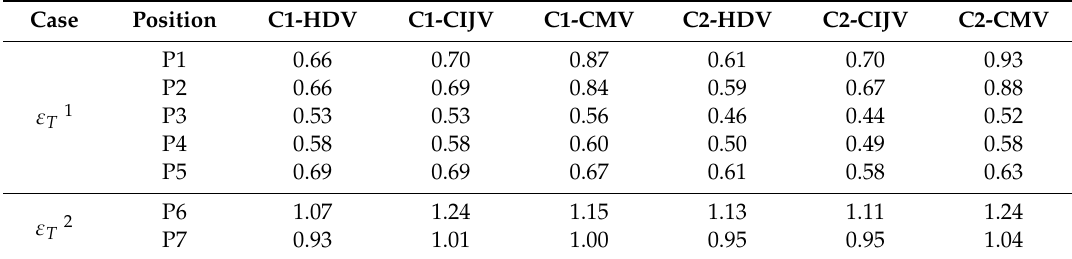
Table 5. Average ε T in locations P1–P7 for all